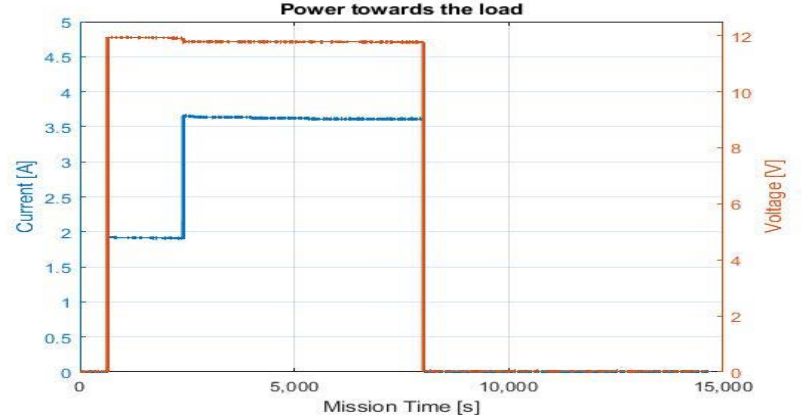
Figure 9. Power consumption during the functional tests.